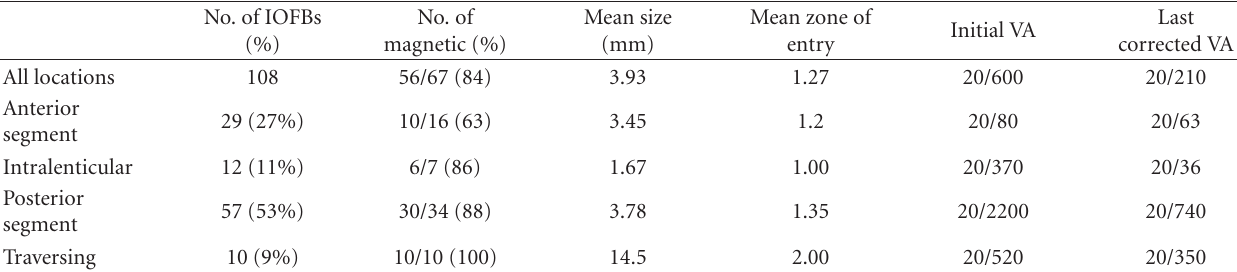
Table 1: IOFB characteristics and visual acuity by location.